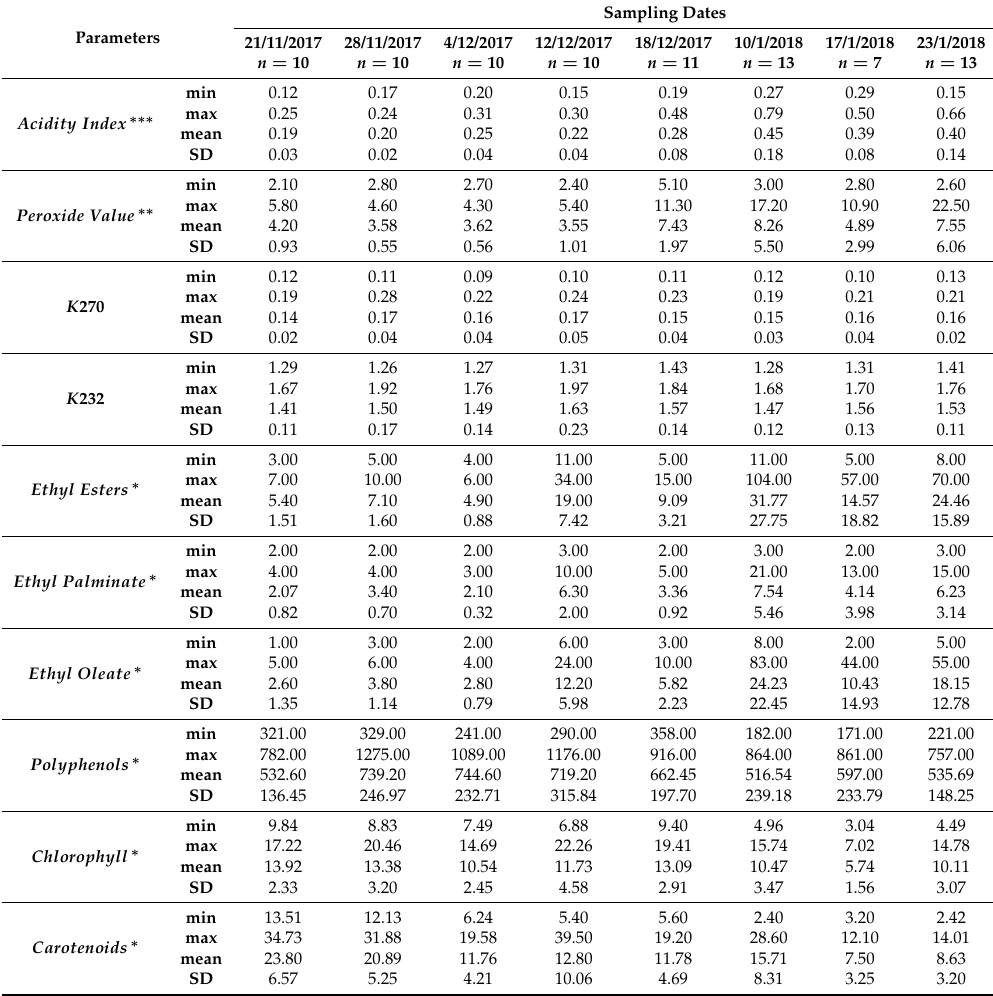
Table 2. Laboratory results for the analytical parameters. The number of samples per day is indicated by “ n